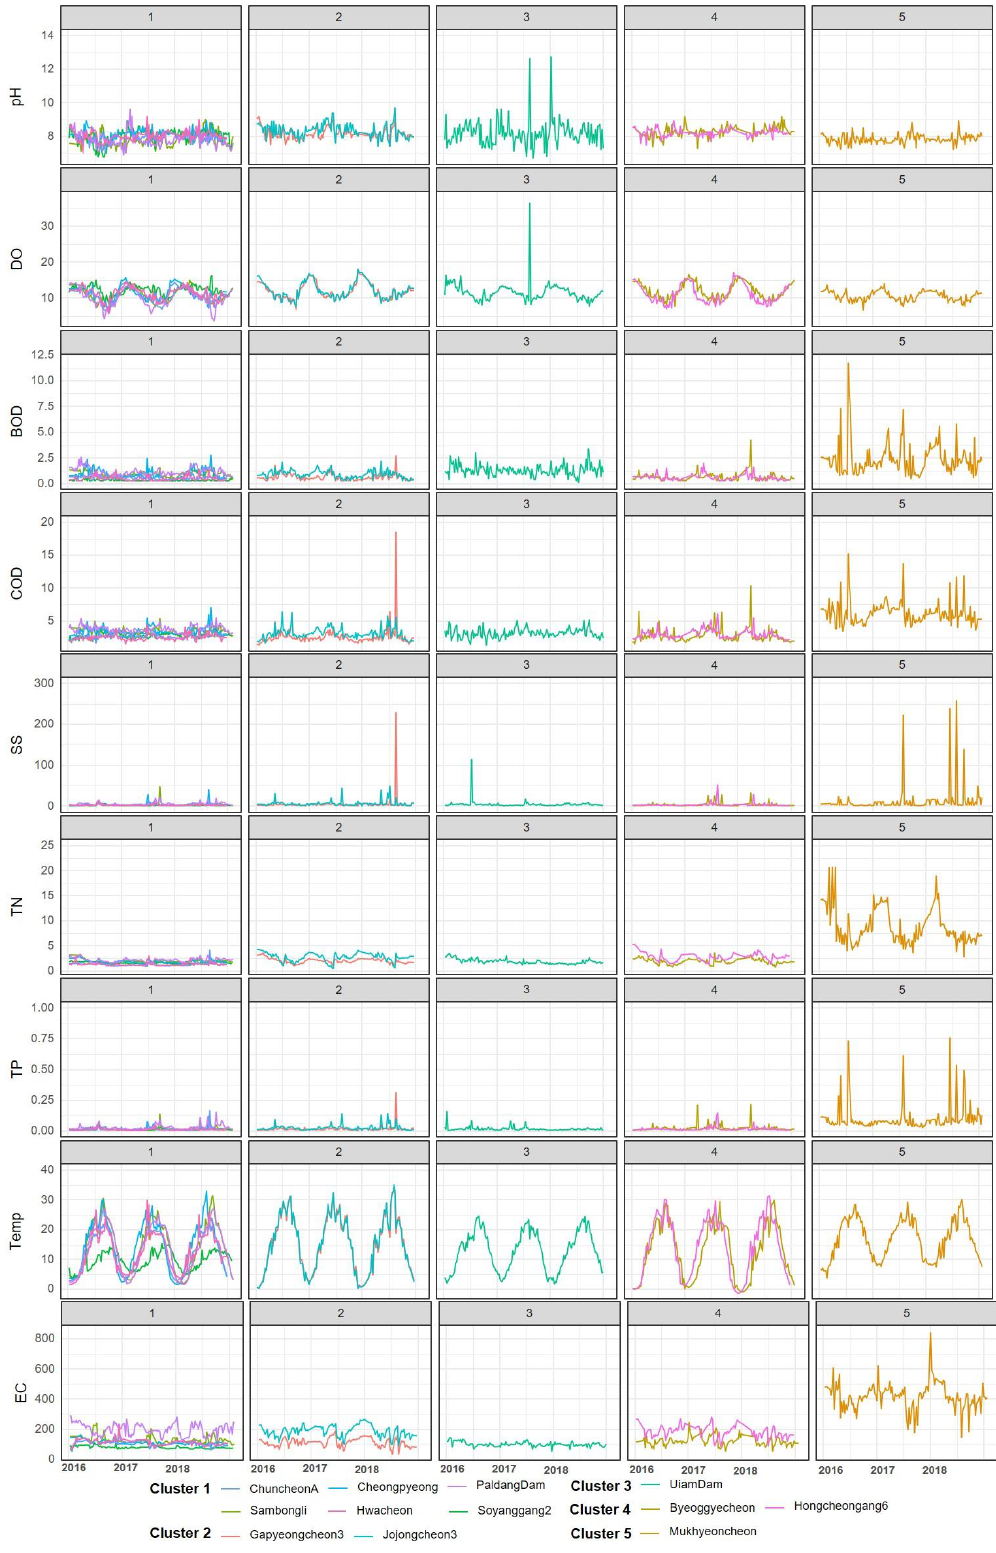
Figure 8. Cluster-specific time series plots for each variable observed between 2016 and 2018 when using the Euclidean algorithm about Cluster 1 (1), Cluster 2 (2), Cluster 3 (3), Cluster 4 (4), and Cluster 5 (5).